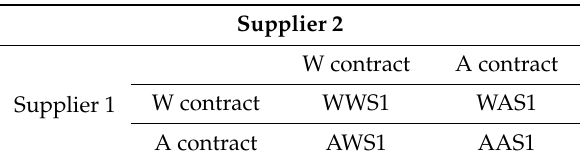
Table 2. The four game